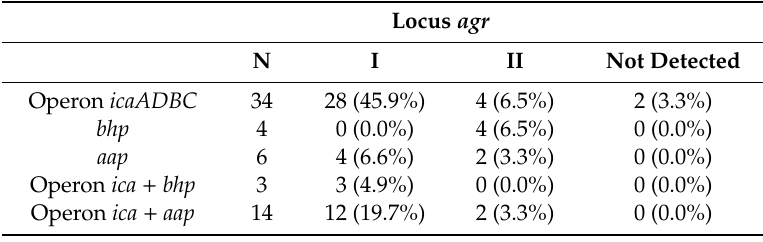
Table 2. Relationship of genes related to biofilm production and detection of accessory gene regulator ( agr ) locus in Staphylococcus epidermidis positive by the reverse transcription polymerase chain reaction (RT-PCR) technique.